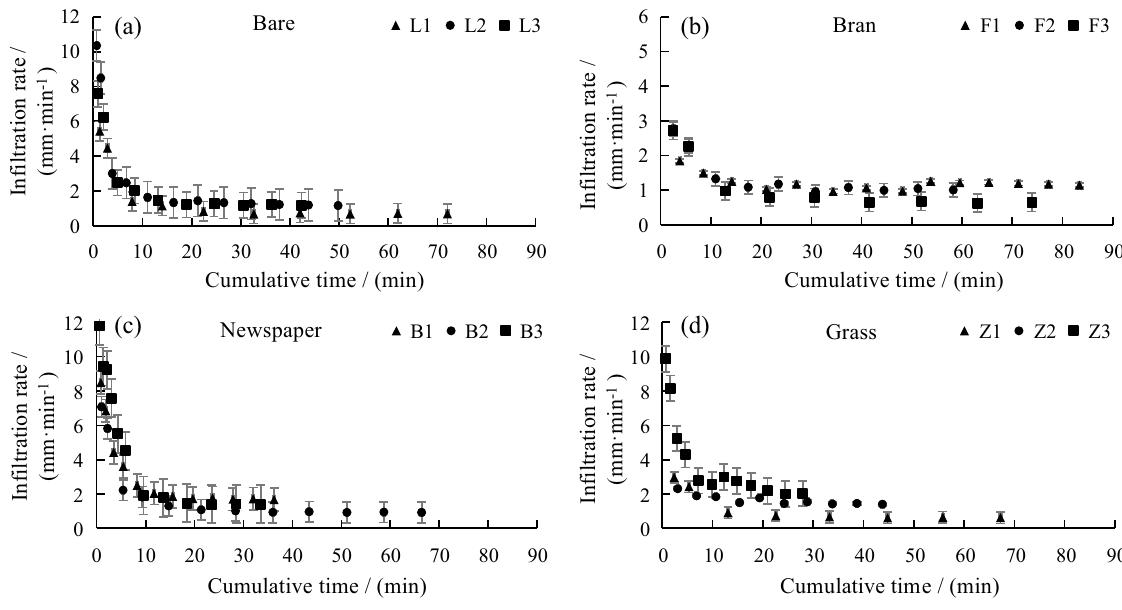
Figure 2. Variation characteristics of soil infiltration rate of different organic mulches.